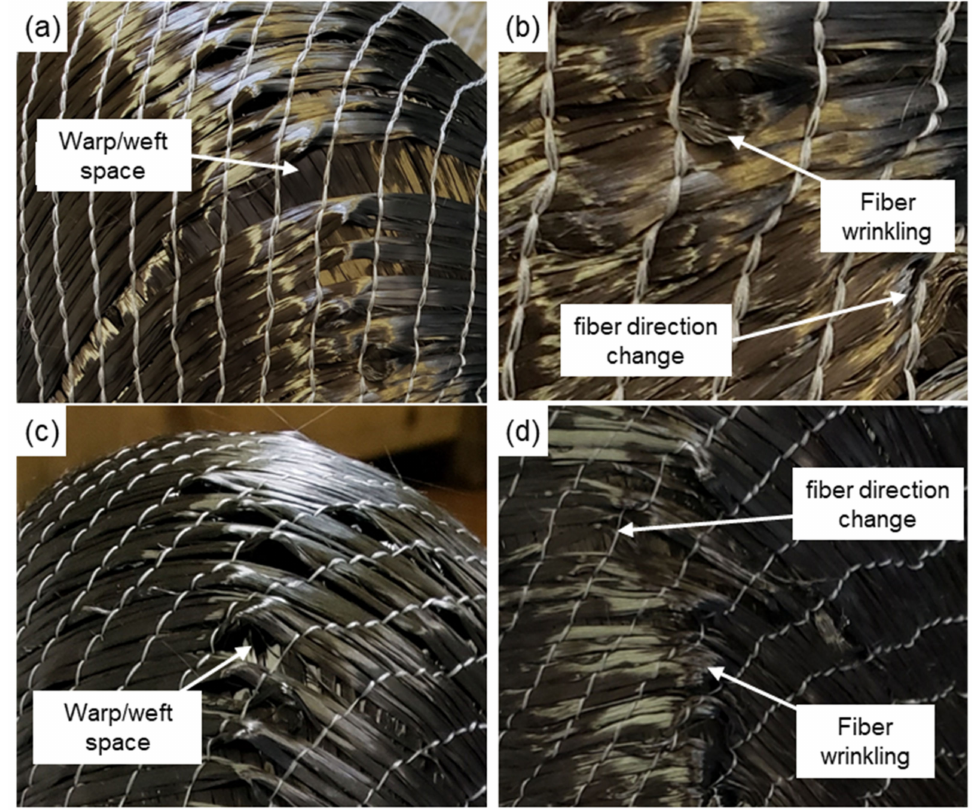
Figure 7. Optical microscopic images of fabric deformation: ( a , b ) NCF 0/90; ( c , d ) NCF ± 45.